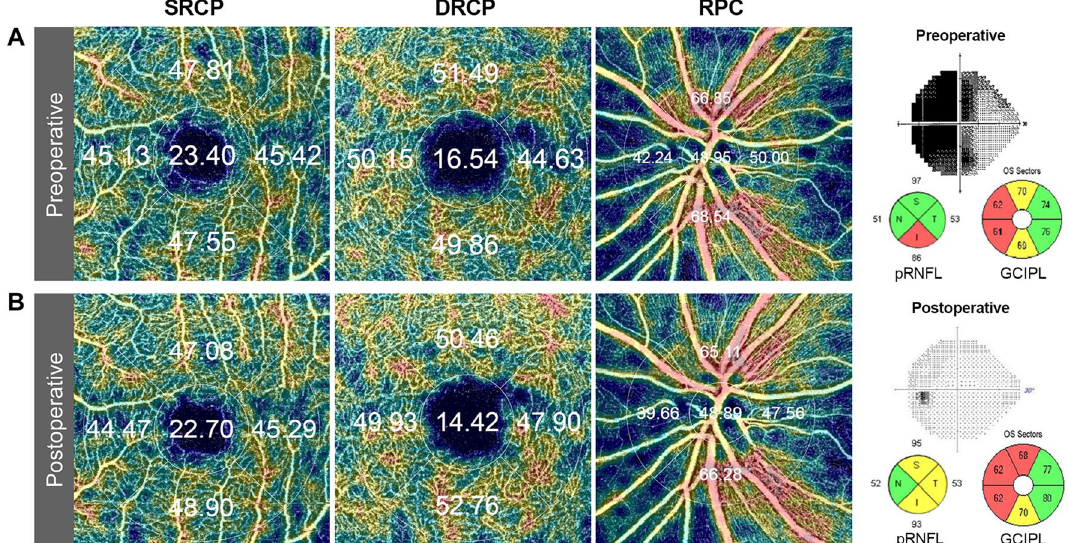
Figure 1. Representative ( A ) preoperative and ( B ) postoperative test results of a study patient with a pituitary adenoma. Optical coherence tomography angiography color-coded density map with image qualities of 72 in the superficial retinal capillary plexus (SRCP), deep retinal capillary plexus (DRCP), and radial peripapillary capillary (RPC) segments showing the automated measurement of vessel density with the percentage via auto-segmentation. The preoperative visual field of the patient showed temporal hemianopsia that completely recovered after surgery. The peripapillary retinal nerve fiber layer (pRNFL) and the ganglion cell-inner plexiform layer (GCIPL) thickness of the patient are presented pre- and